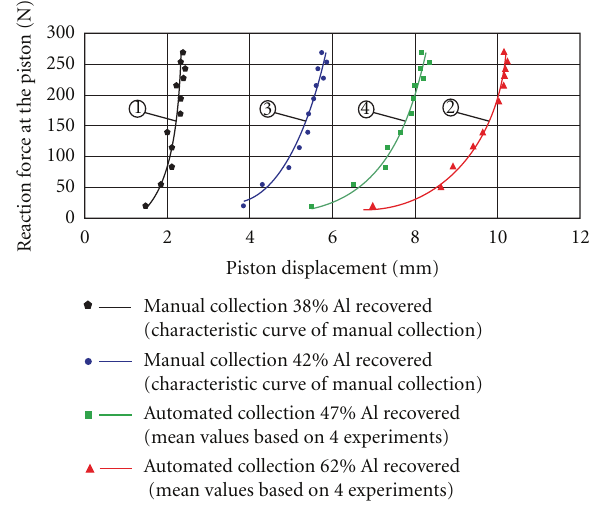
Figure 4: Experimentally determined values for 4 varying cases with the first method of a single collecting process per